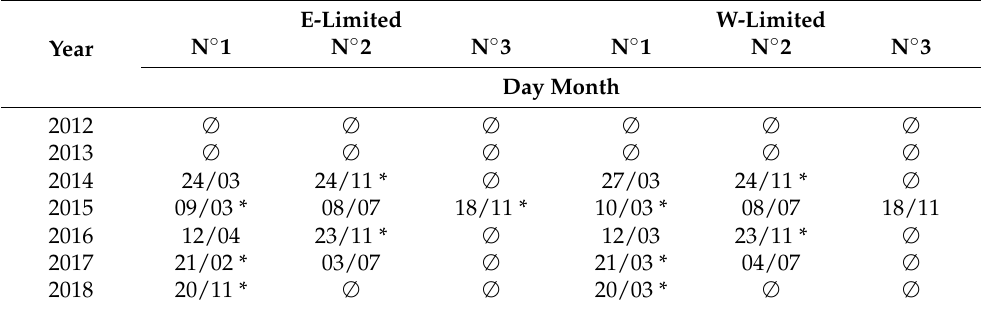
Figure A3. Quantile-quantile (Q-Q) plot comparing for each year and study site the distribution of the gross drained nitrogen (Sample) with a normal distribution (Theoretical). The black line represent a perfect correlation. The grey ribbon represents the 95% confidence level interval. Table A1. Fertilizer application dates for Rollesbroich soil in Rollesbroich, the energy-limited site (E-limited) and Selhausen, the water-limited site (W-limited). “ ∅” indicates that no fertilization occurred.